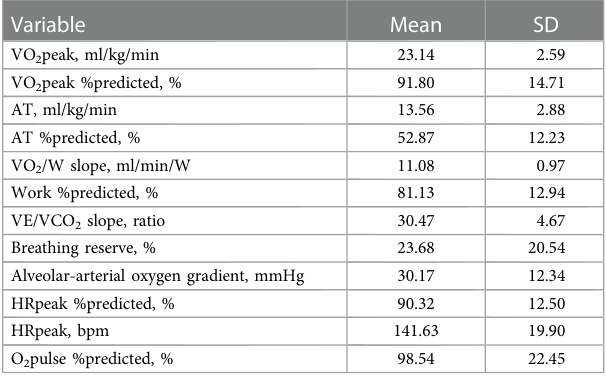
TABLE 3 Cohort ’ s CPET